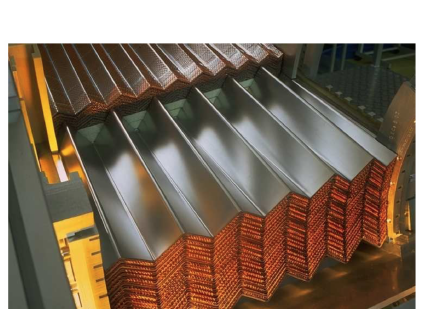
Figure 2: Cut-away view of an end-cap cryostat showing the positions of the three end-cap calorimeters. The outer radius of the cylindrical cryostat vessel is 2.25 m and the length of the cryostat is 3.17 m.